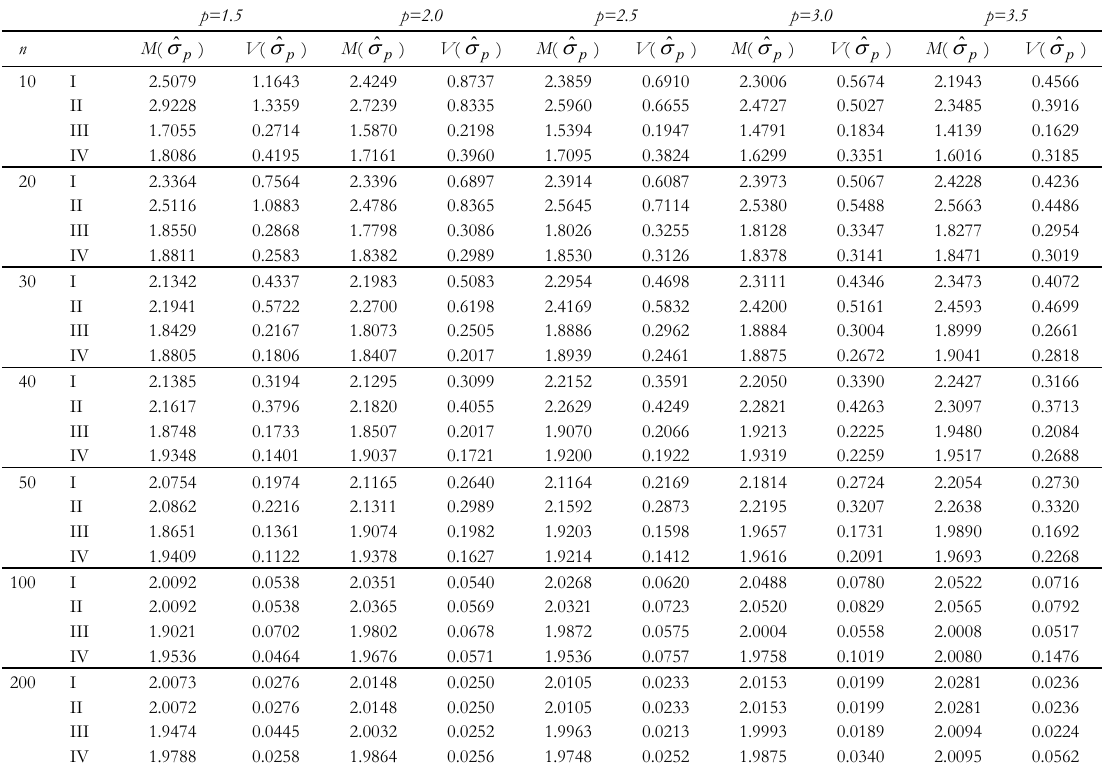
Arithmetic means (M) and variances (V) of the power deviation of order p estimates for the four used methods (I=whole log-likelihood, II=profile log-likelihood, III=conditional profile log-likelihood, IV=method based on the index ˆ VI )